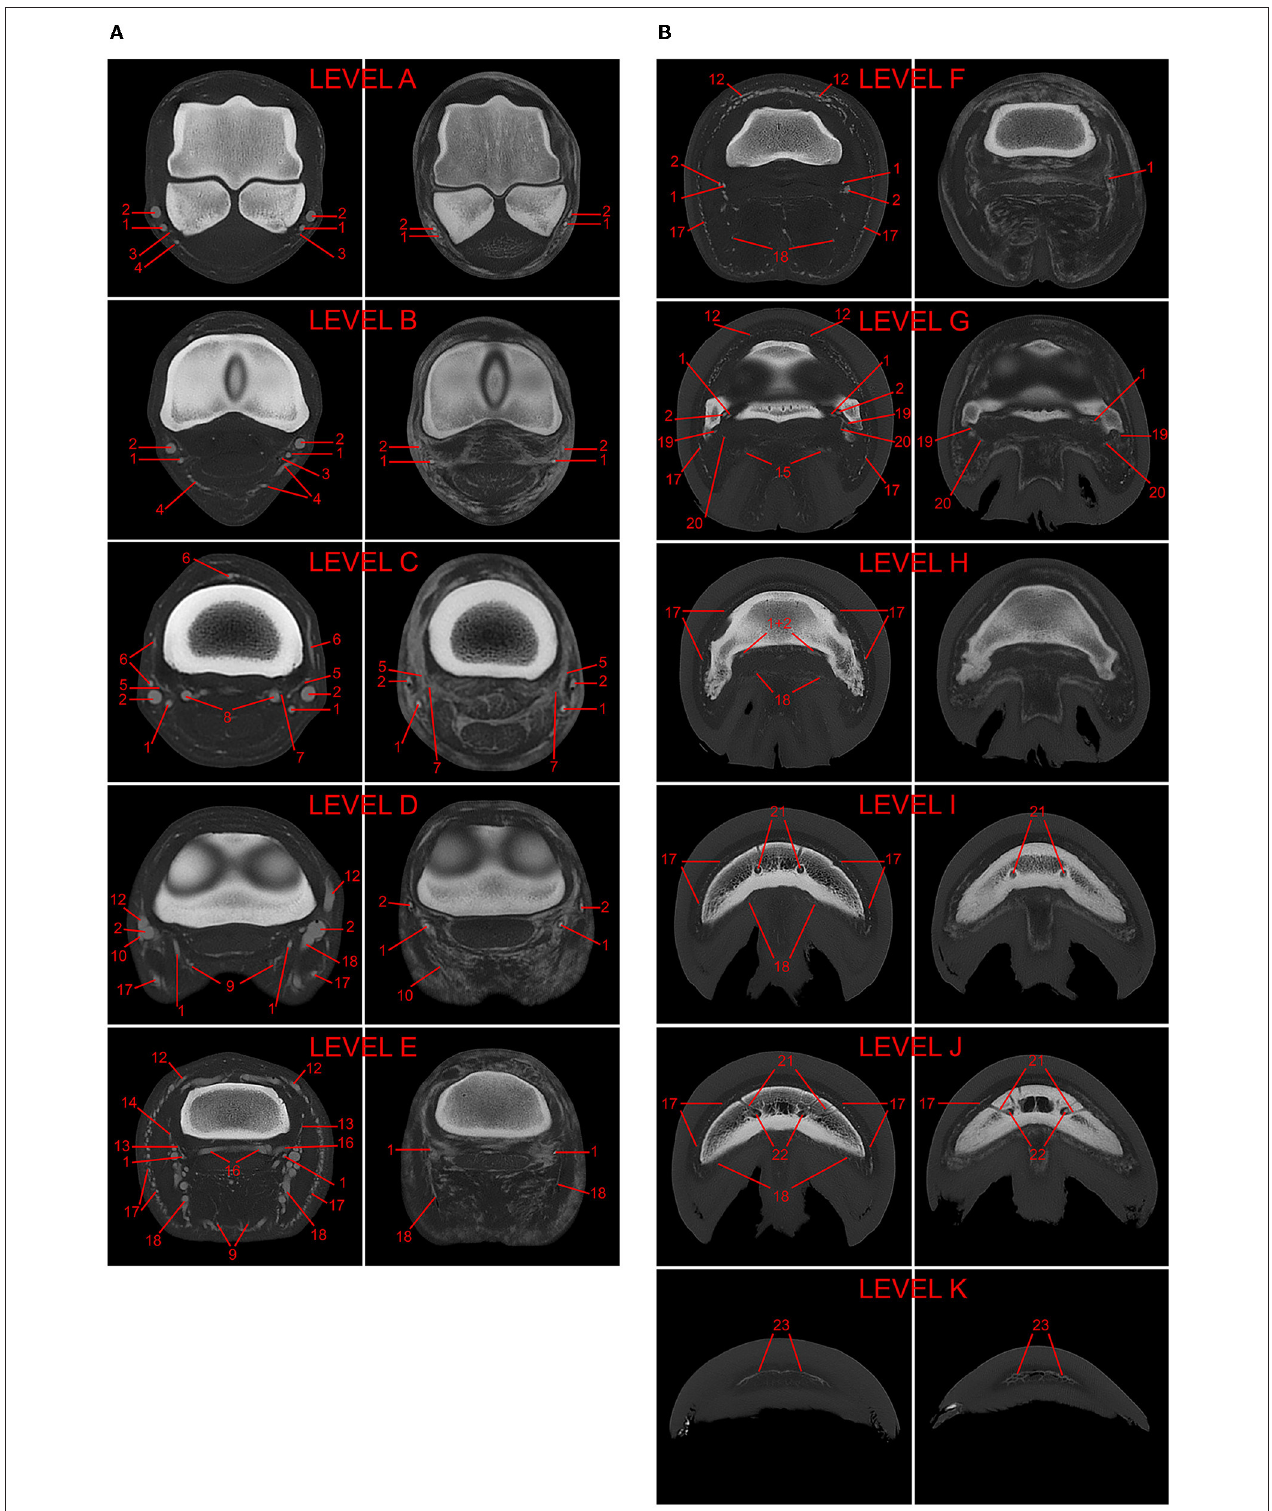
FIGURE 2 | (A) 3D-reconstructed post-mortem CT-angiography of an equine distal forelimb after perfusion with a lipophilic contrast agent. The 11 evaluated levels are marked A–K in this reconstruction. (B) Comparison of paired transverse CT images in a bone algorithm (WW/WL: 800/2,000) at each of the 11 evaluated levels